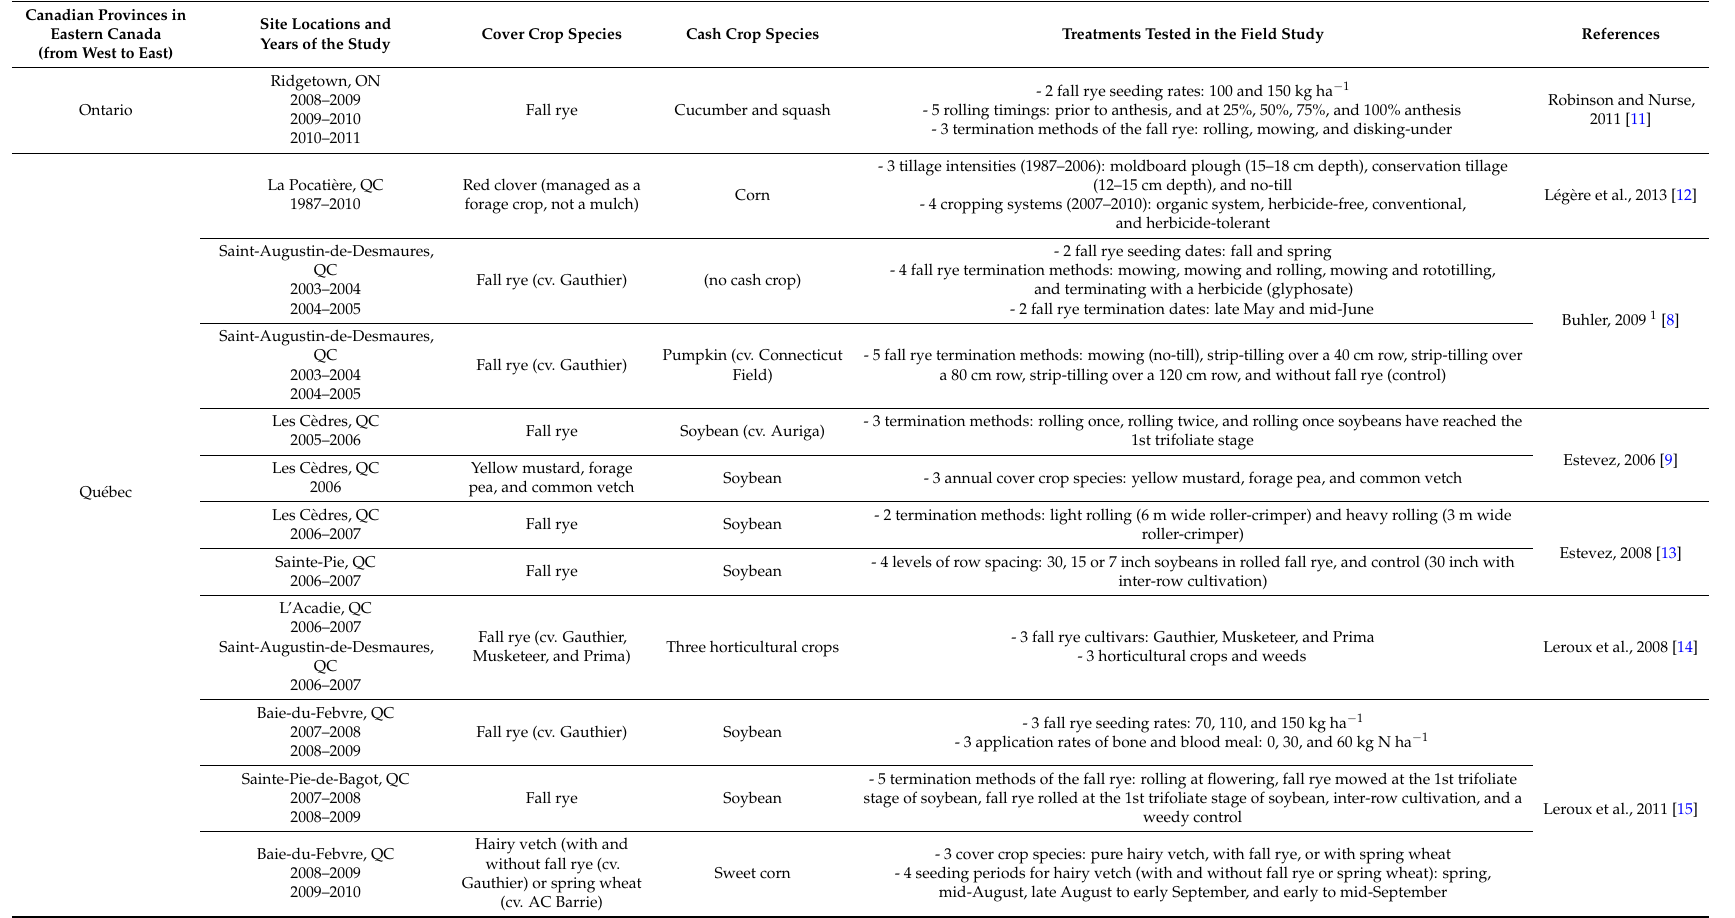
Table 1. Organic no-till field trials conducted in Eastern Canada between 1987 and 2016. Canadian Provinces in Eastern